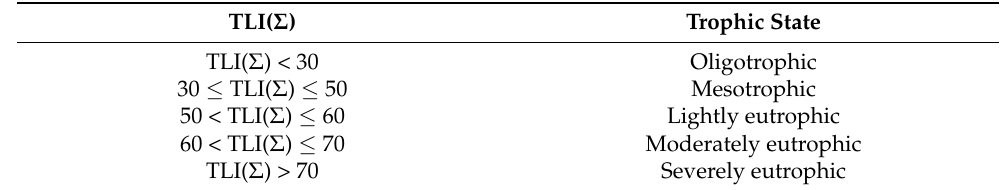
Table 1. Classification of nutritional status of lakes